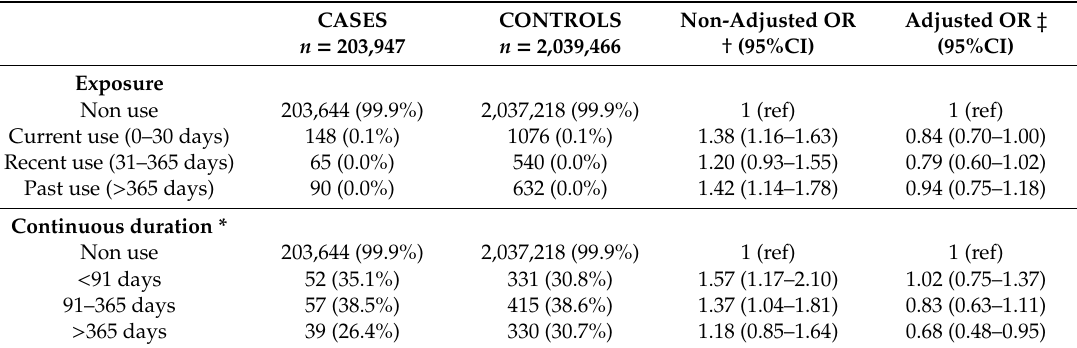
Table 5. Use of valproic acid and risk of clinical infections by herpesviruses.